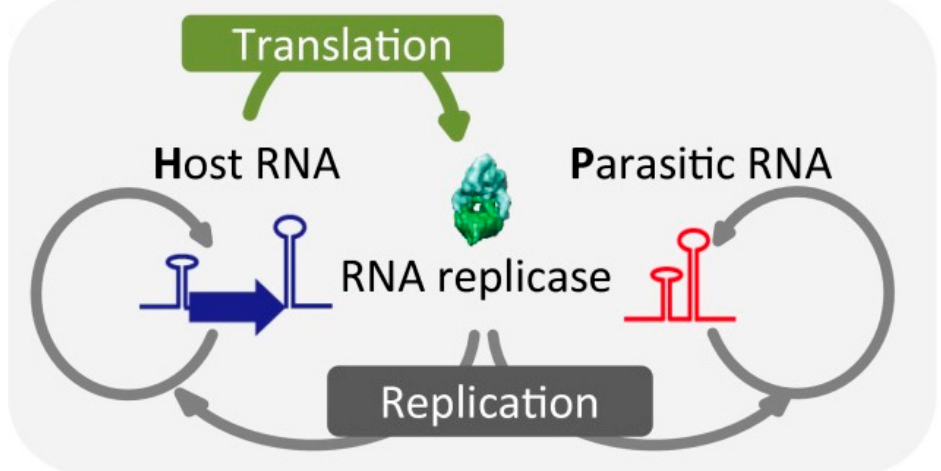
Figure 5. Replication scheme described in [65]. Briefly, a host RNA (blue) contains a sequence which codes for translation of an RNA replicase enzyme. This RNA replicase in turn catalyzes the replication of the host RNA. However, a parasitic RNA (which also replicates by the replicase enzyme), but without the replicase coding region, also exists in the system. Reprinted with permission from